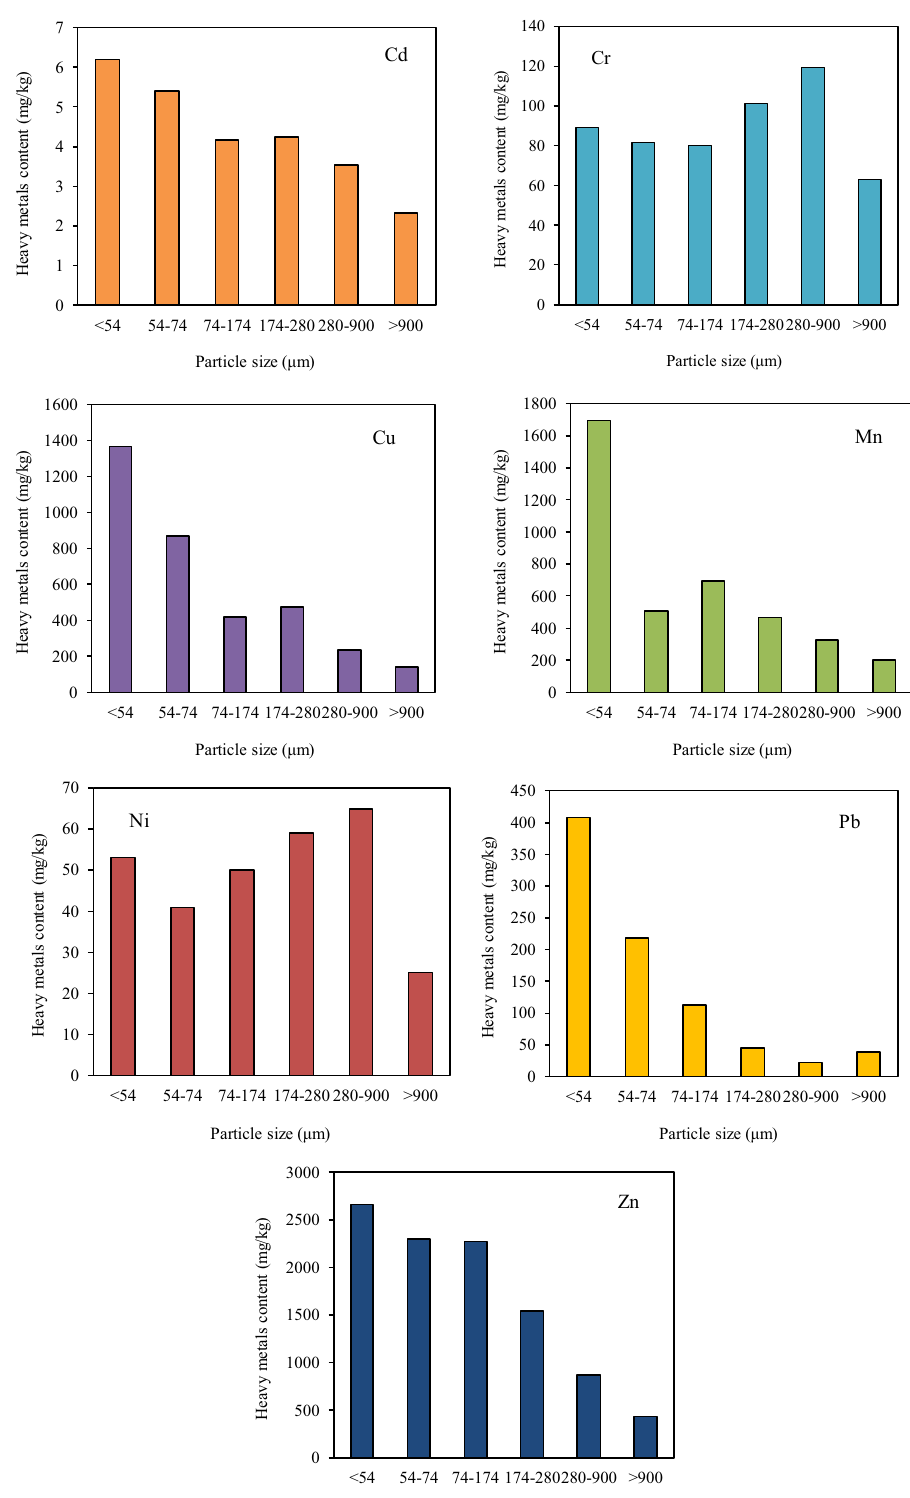
Figure 2. The total content and percentage of seven heavy metals in fly ash with different particle size